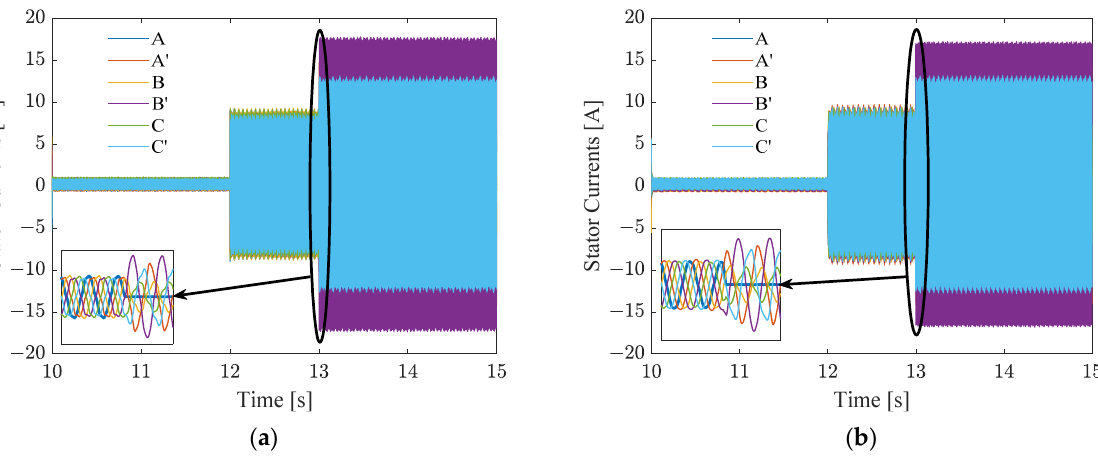
Figure 11. Faulty mode results: ( a ) stator currents with PI controller; ( b ) stator currents with FLC. One can see in Figure 9a (PI controller) that the transition between − 1 A and − 15 A induces ripples in the direct current, and these ripples become more significant after the phase loss. These ripples in the dq current components are reflected in the